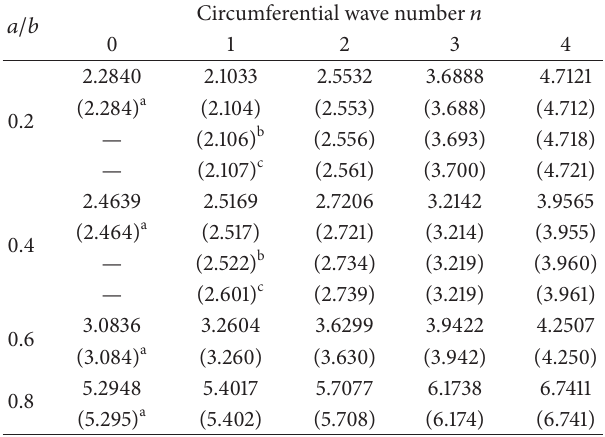
Table 4: Frequency parameters, Ω = 𝜔𝑏(𝜌(1 − V 2 )/𝐸) 1/2 , for C-F annular plates with various cutout ratios.